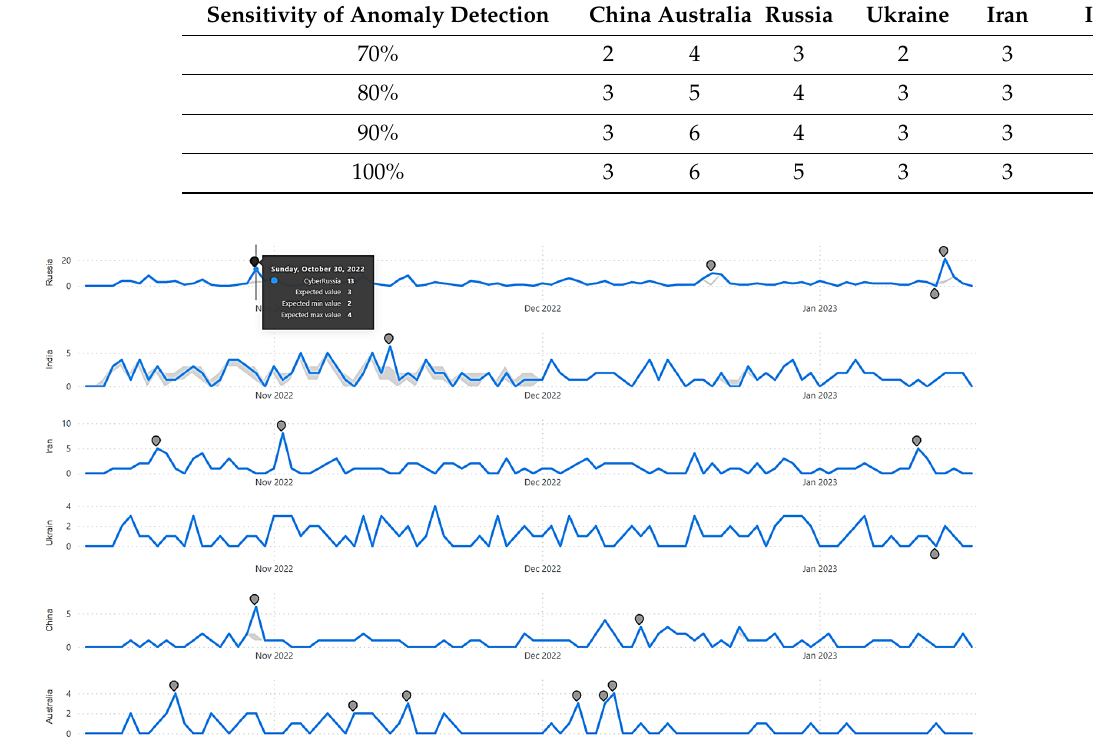
Figure 3. CNN-based anomaly detection executed on cyber threat indexes within a Windows envi- ronment.